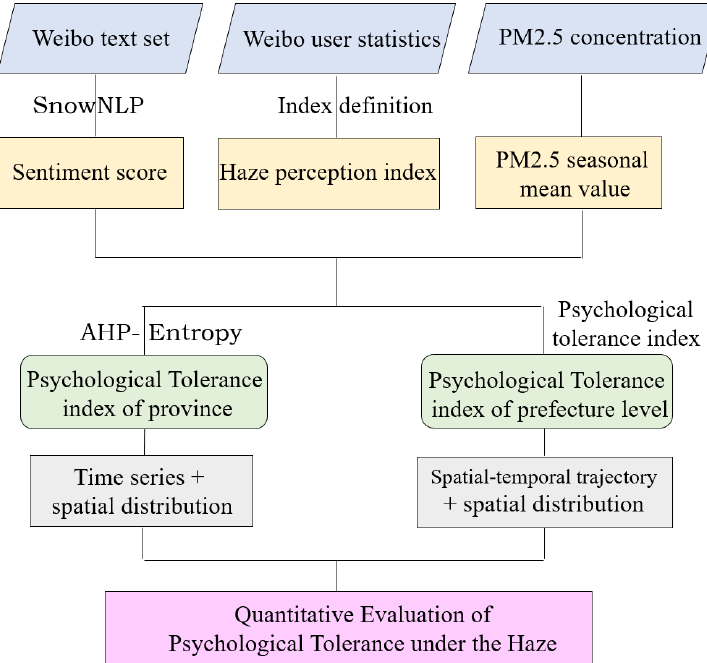
Figure 2. A flowchart depicting the techniques used.